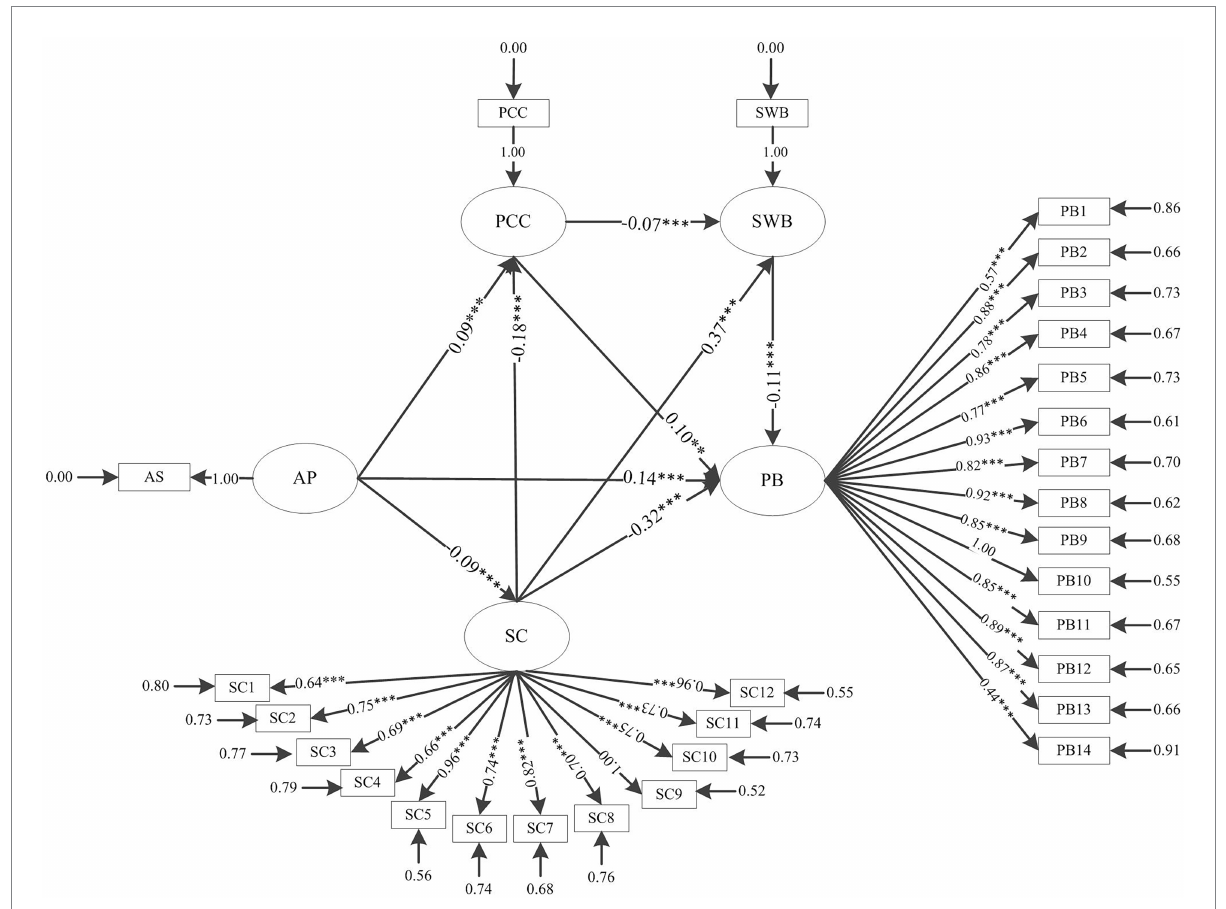
FIGURE 2 Structural equation modeling results. Note : AP, academic pressure (the influence of academic pressure on adolescent problem behavior); SC, self-control; PCC, parent–child conflict; SWB, subjective well-being; PB, problem behavior; ** p < 0.01, *** p <